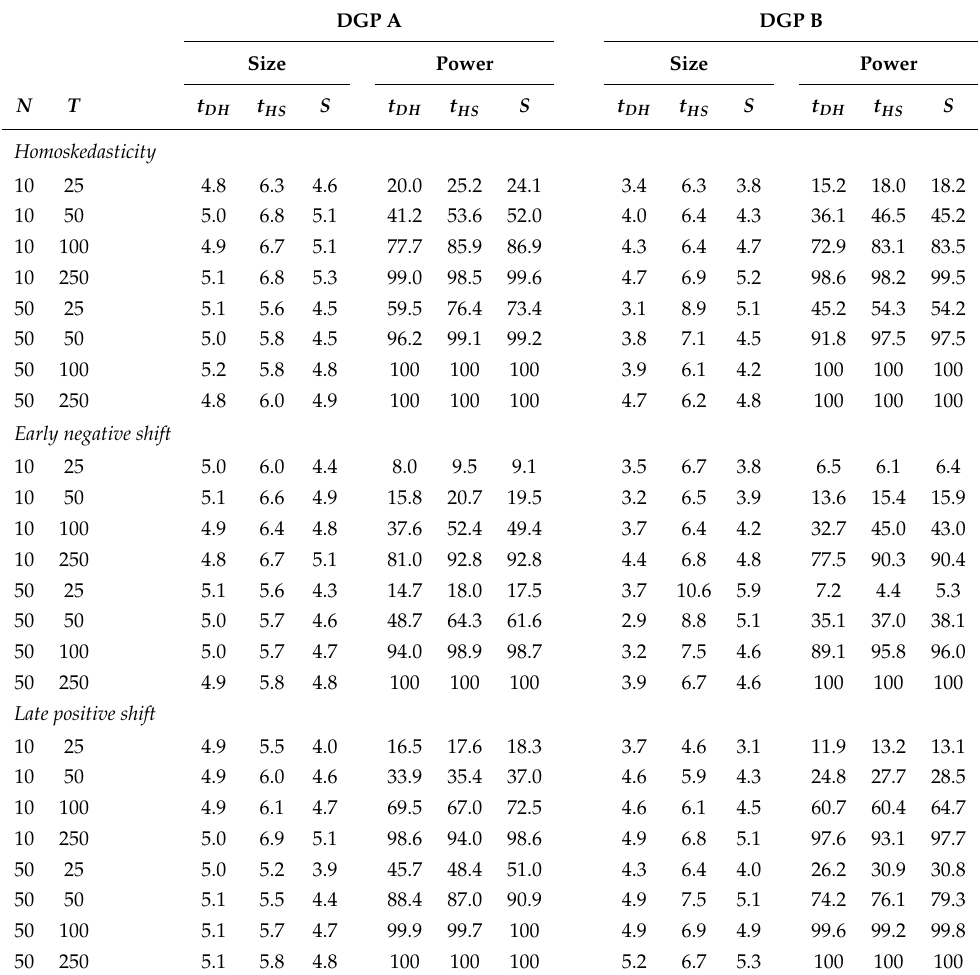
Table A4. Rejection frequencies in cross-dependent panels—common factor. γ i ∼ iid U ( 0.9,1 ) , µ i ∼ iid U ( 0,0.02 ) , v t ∼ N ( 0,1 ) , λ i ∼ iid U ( 0,0.02 ) . DGP B: θ i ∼ iid U ( 0.2,0.4 ) . Power is computed using size-adjusted 5% critical values; 25,000 replications were